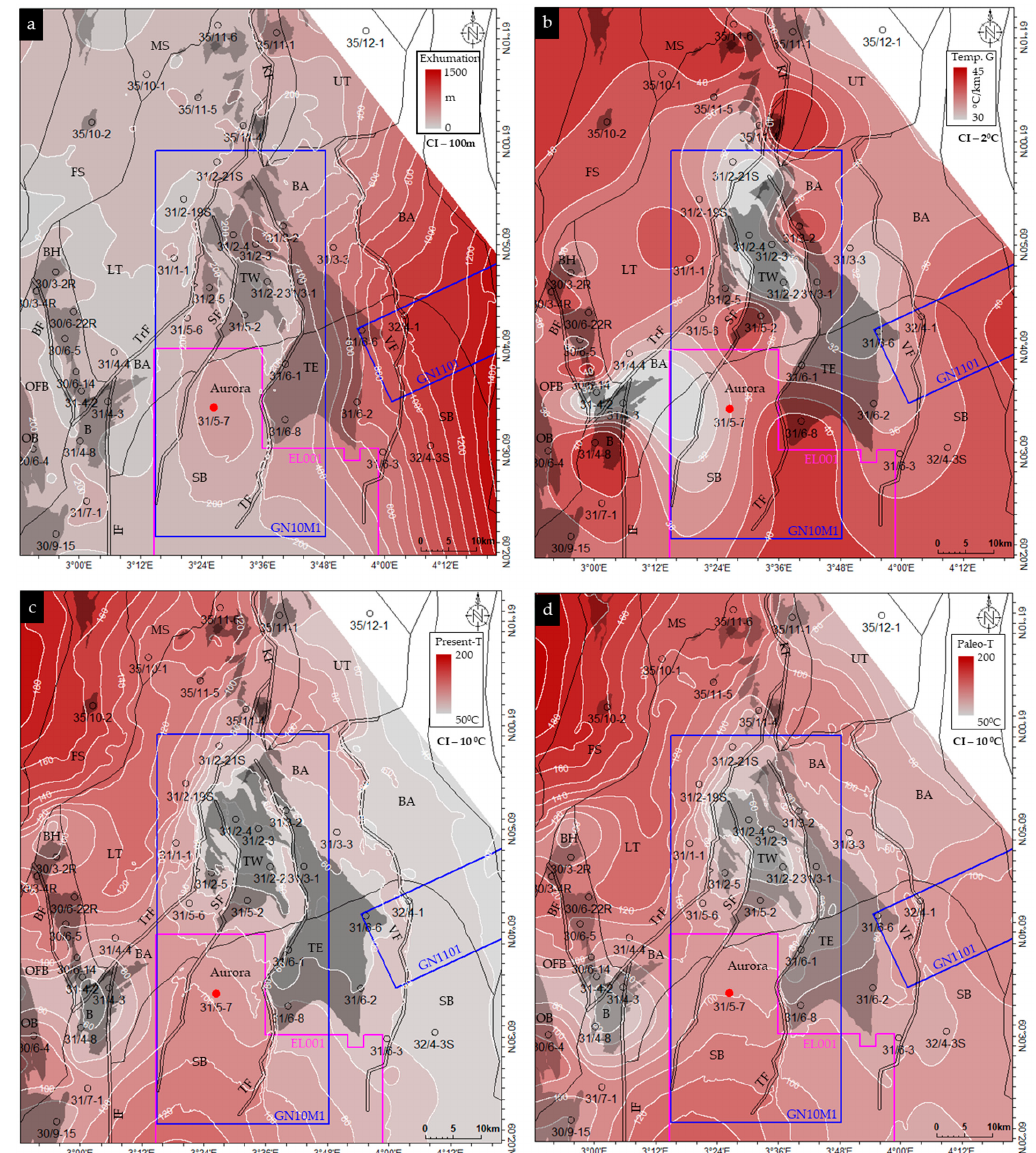
Figure 10. The average exhumation map ( a ) and temperature gradient map ( b ) for the study area show the differential uplift and temperature variations. The present ( c ) and paleo ( d ) temperature distribution maps of the lower Drake unit calculated using exhumation and temperature gradient analysis display the variation and the maximum temperature experienced by the caprocks in the study area. The paleo-temperature map on top of the caprock surface represents the mechanical and chemical compaction zones. The contour interval (CI) of all maps is shown in the legend.